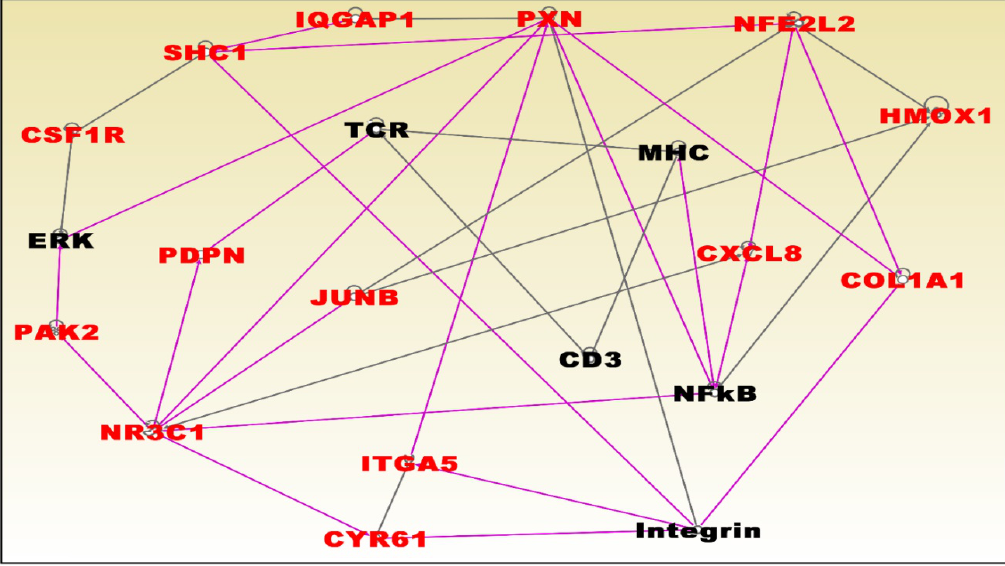
Figure 7. Molecular networks predicted to significantly associate obesity with TNBC in postmenopausal women. Gene symbols in red fonts were predicted to be highly significantly associated with obesity. Genes in black symbols are predicted to be functionally related.